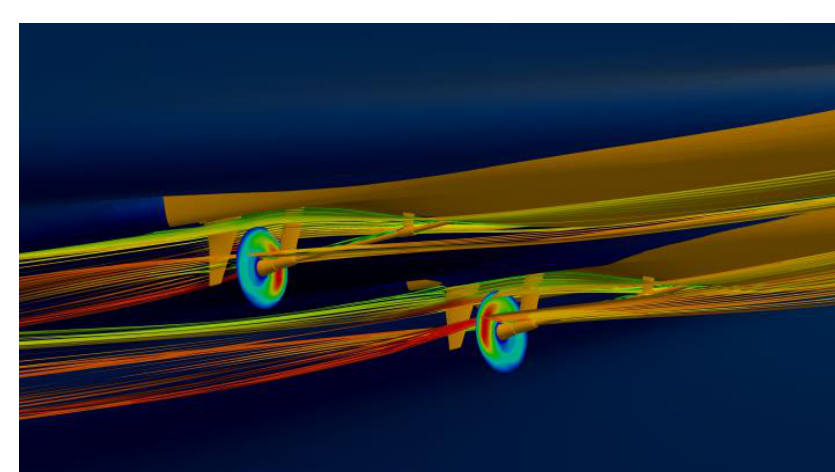
Figure 13. Streamlines through propeller discs and propeller body force distribution at 23 knots.